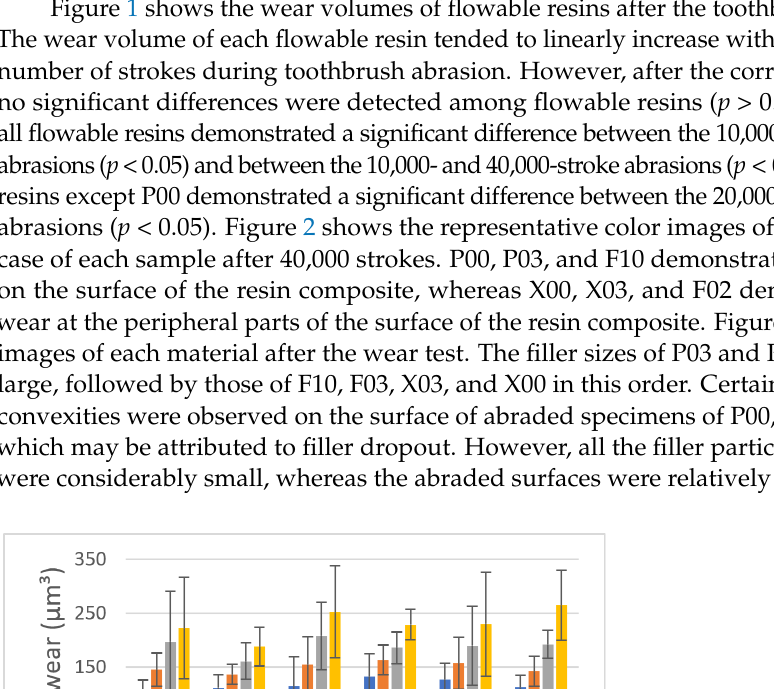
Figure 2. Representative color images showing the wear depth in each sample after 40,000 strokes. P00, P03, and F10 show complete wear on the surface of the resin composite, whereas X00, X03, and F02 show partial wear at the peripheral parts of the surface of the resin composite.